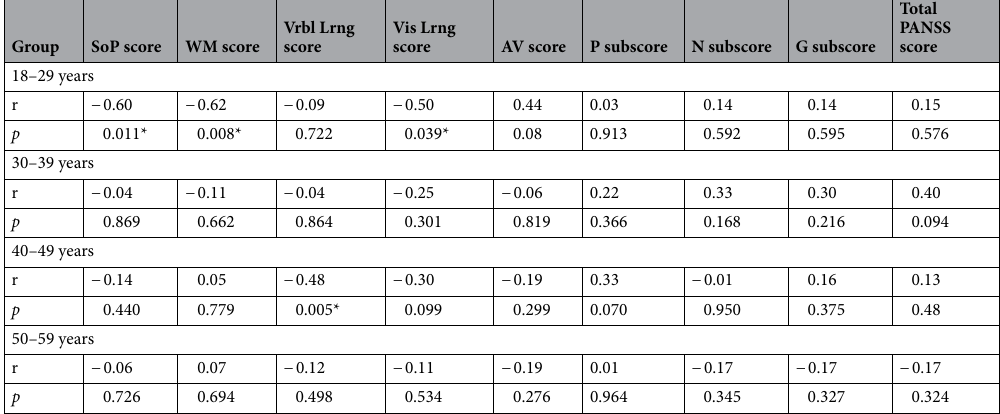
Table 3. The correlations between the plasma Hcy levels and clinical symptoms or cognitive deficits in patients with schizophrenia across age groups. Hcy homocysteine, SoP speed of processing, Vrbl Lrng verbal learning and memory, Vis Lmg visual learning and memory, WM working memory, AV attention/vigilance, P positive symptom, N negative symptom, G general psychopathology syndrome, r Pearson’s correlation coefficient, PANSS the Positive and Negative Syndrome Scales. * p <